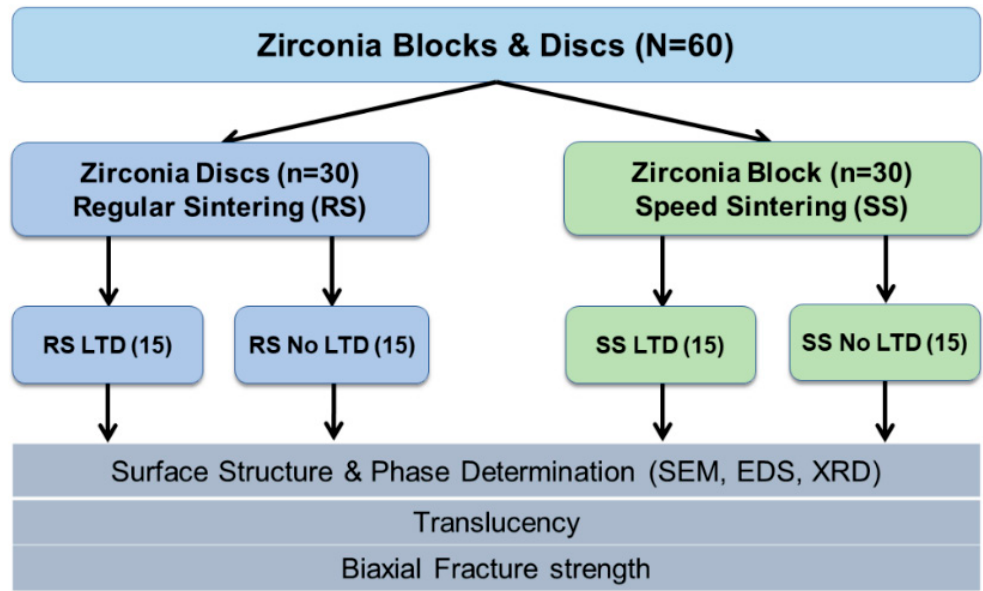
Figure 2. Overview method of the study. LTD = low temperature degradation.